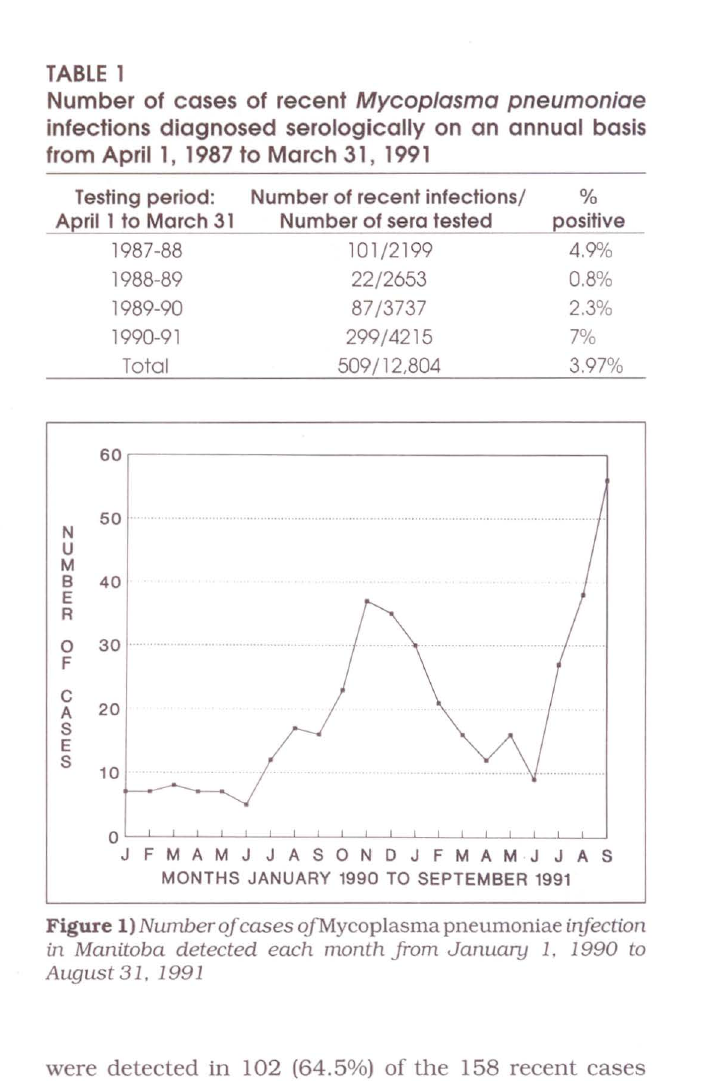
Figure 1) Number of cases ojMycoplasma pneumoniae irifection in Manitoba detected each month .from January 1. 1990 to August 31.